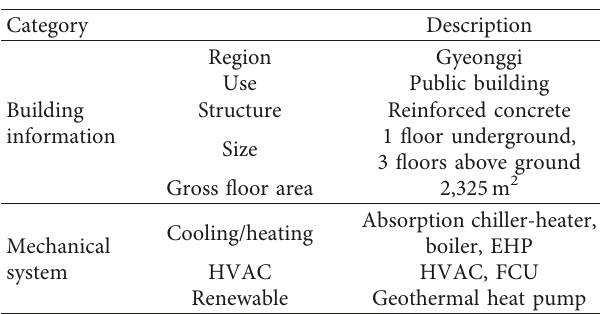
Table 5: Overview of the target